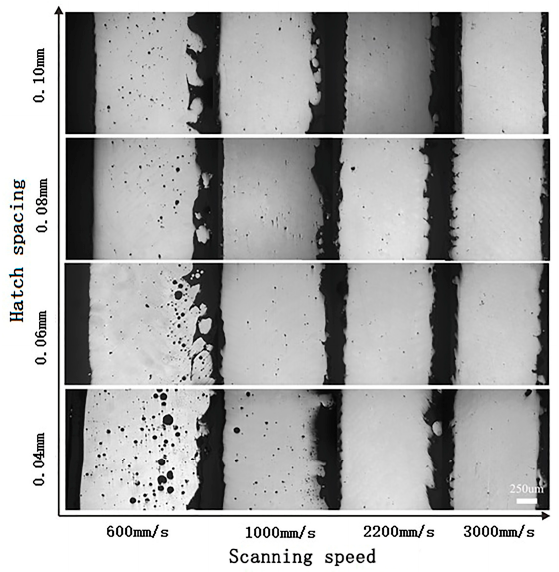
Figure 6. Metallograph of SLMed struts fabricated at different scanning speed and hatch spacing.